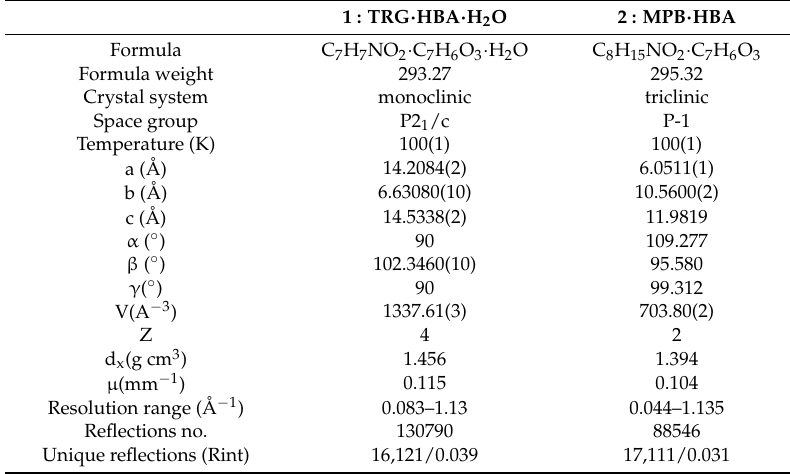
Table 1. Crystallographic measurement and refinement